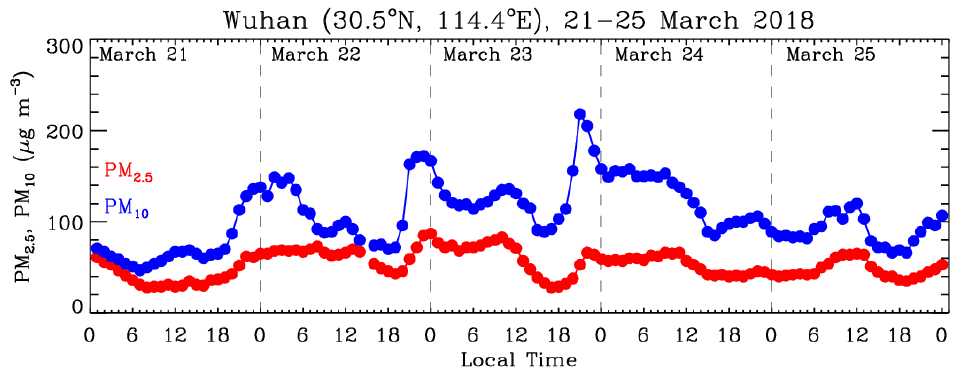
Figure 8. Evolution of surface-observed PM 10 and PM 2.5 concentrations over Wuhan (a mega city in the Jianghan Plain) from 21 March to 25 March 2018.